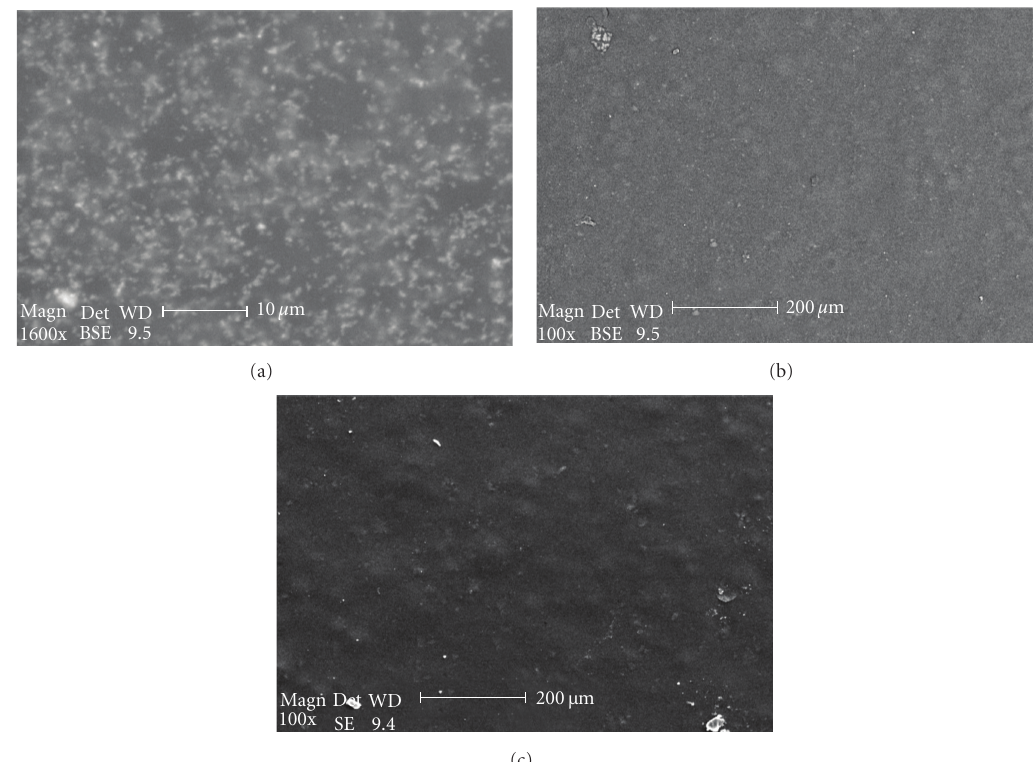
Figure 2: (a) SEM micrograph of sample code, T 5 . (b) SEM micrograph of sample code, nT 5 . (c) SEM micrograph of sample code, nT 7 .